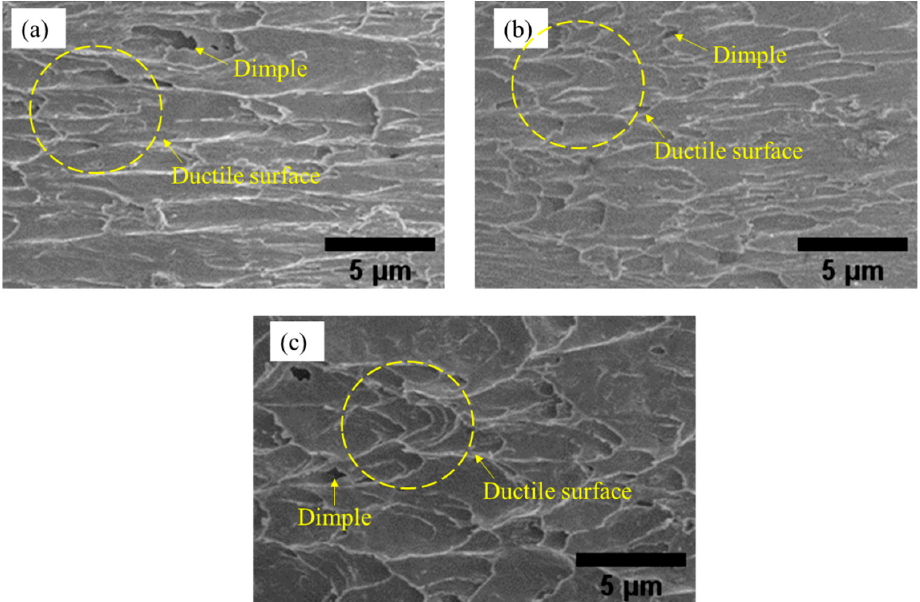
Figure 12. SEM images of fracture surface Sn-0.7Cu lead-free solder on different dimple depths of ( a ) 10 µm, ( b ) 30 µm, and ( c ) 50 µm.